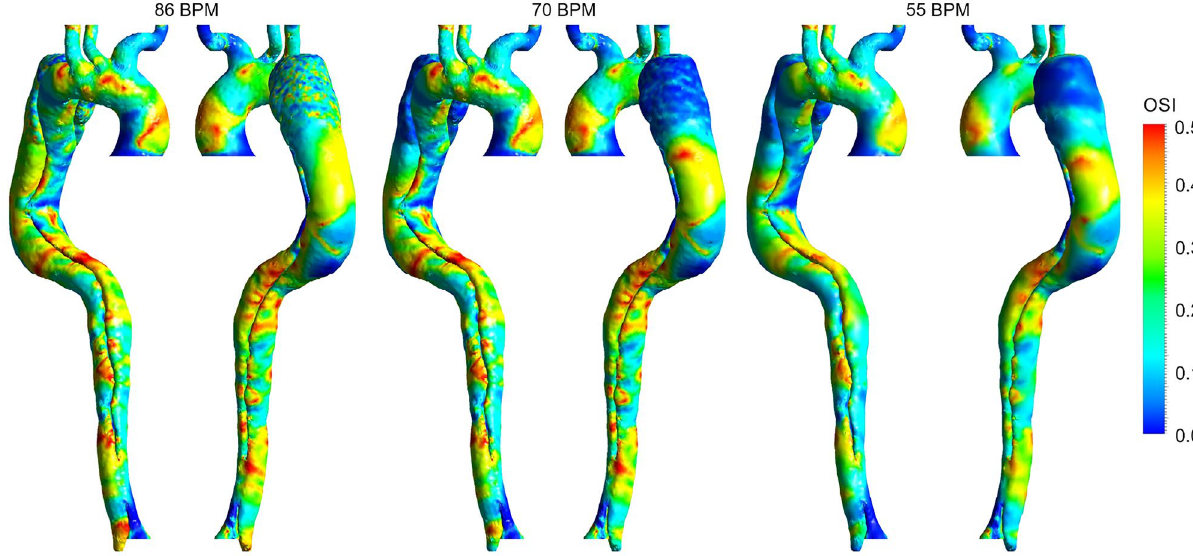
Figure 8. Oscillatory shear index (OSI) distribution for three cases (the scale bar shown in the figure indicates all contours).